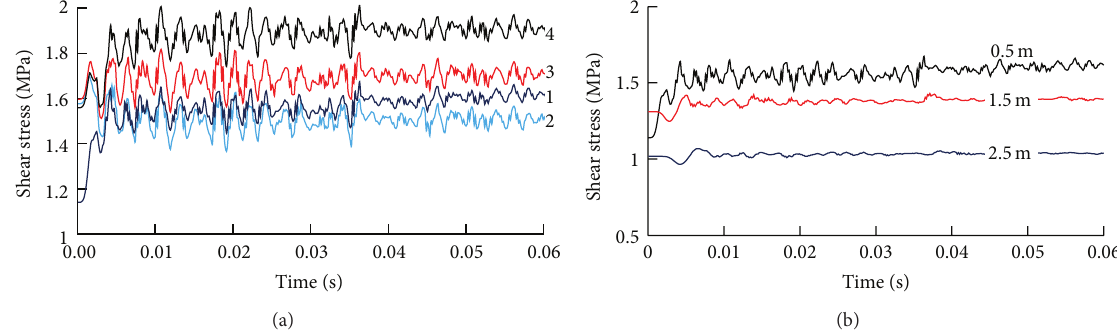
Figure 7: Dynamic response of shear stress along resin in the anchoring system; (a) evolution of shear stress in the anchoring segment of the first row of bolts; (b) evolution of shear stress in the anchoring segment of bolt number 1 for different distances to the head-on.